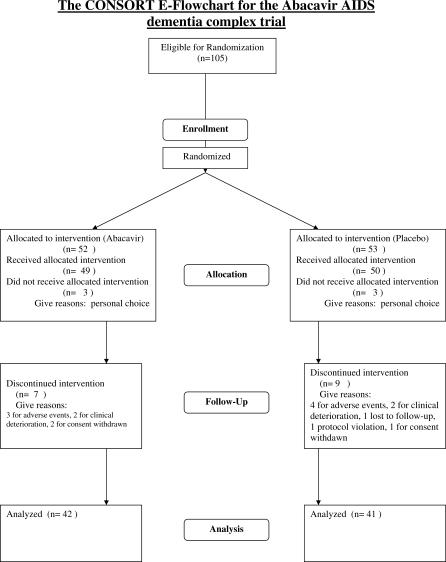
The CONSORT Flowchart for the ABC ADC Trial